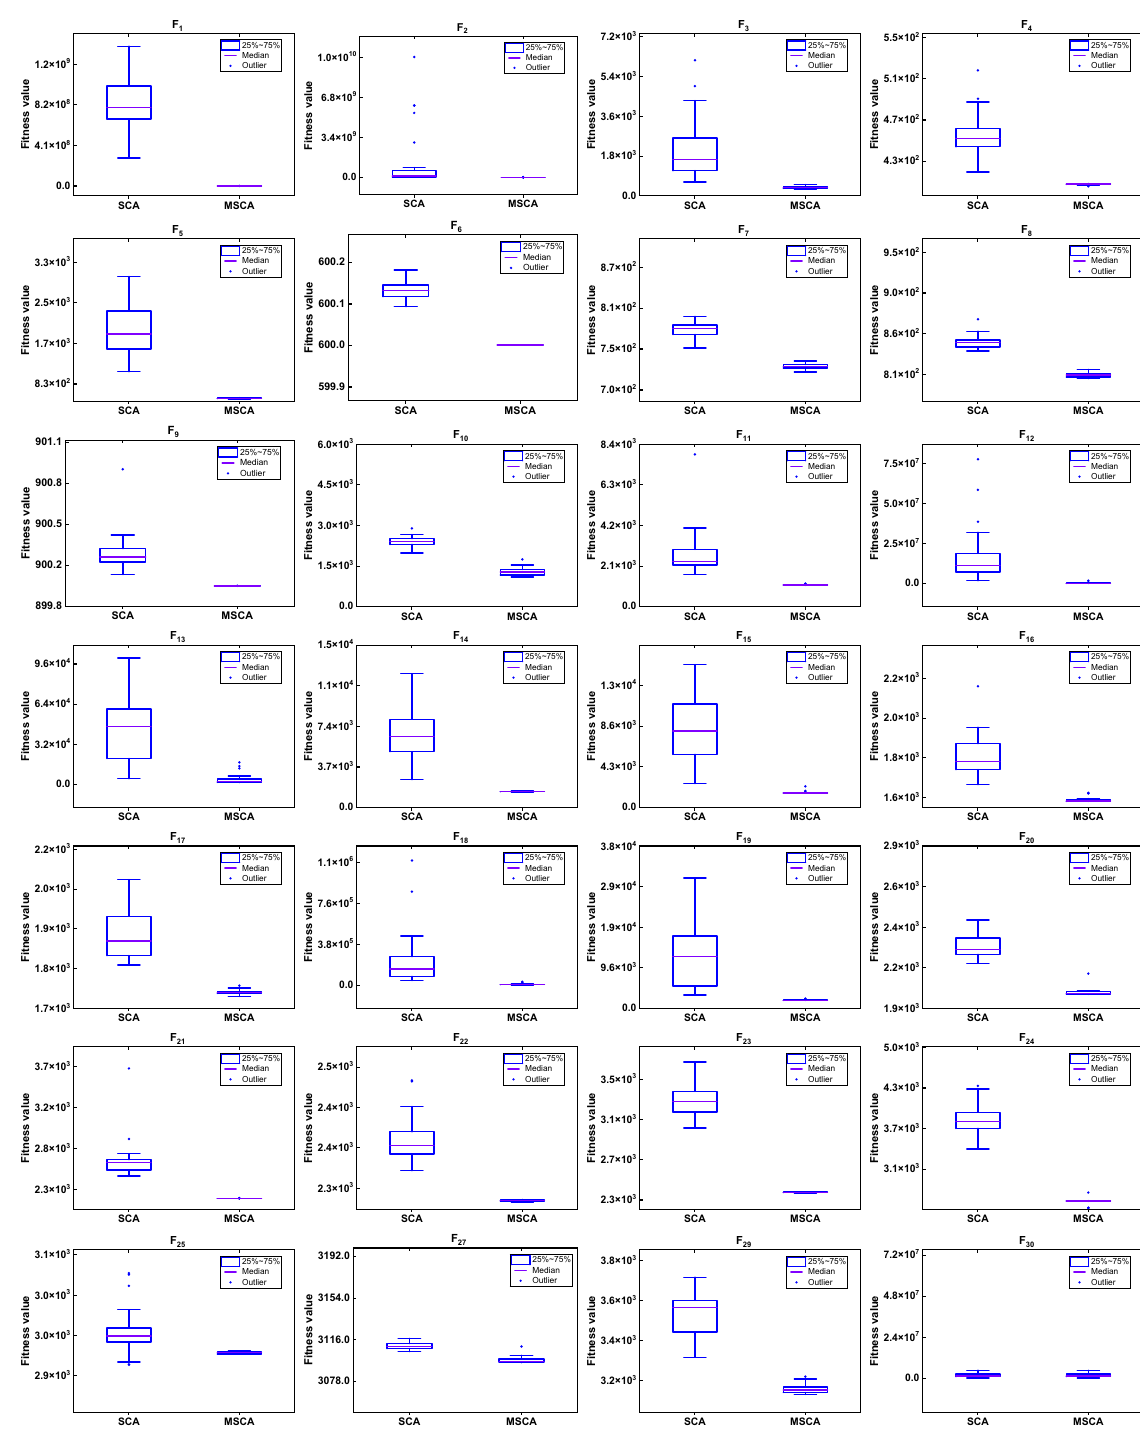
Figure 7. The box-plot of SCA and MSCA on